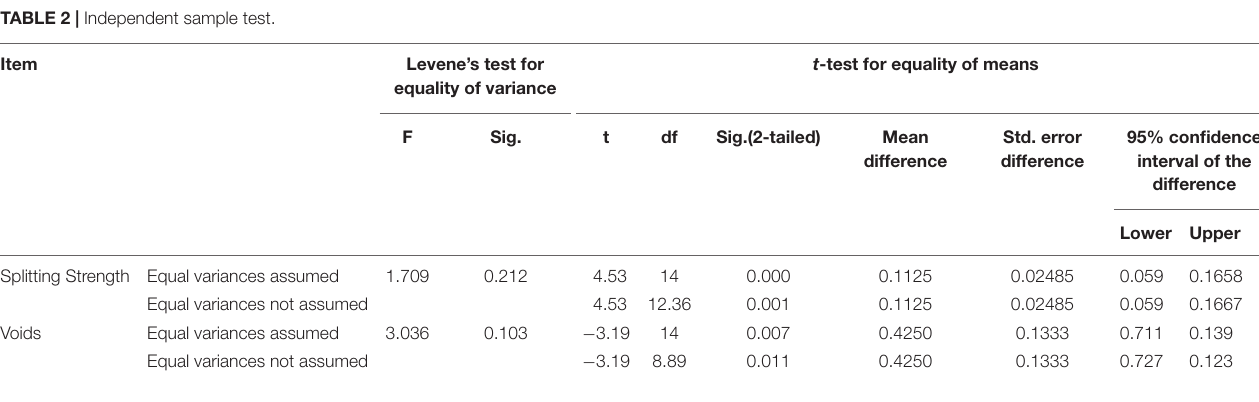
FIGURE 7 | Test results of the voids and splitting strength of cold recycled mixture under different mixing processes: (A) voids test results; (B) splitting strength test results. TABLE 2 | Independent sample